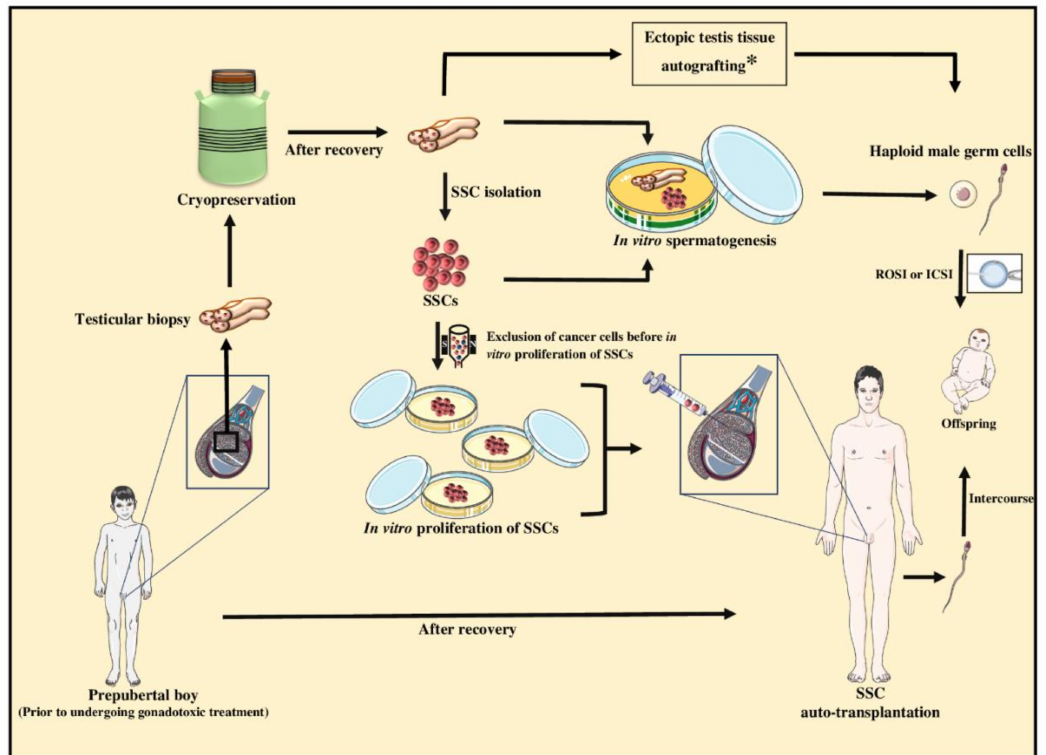
Figure 3. Schematic representation of potential fertility preservation options for prepubertal cancer patients. Testicular biopsies can be collected from prepubertal boys before commencing gonadotoxic cancer treatments. The testicular biopsies can be then cryopreserved as a source of